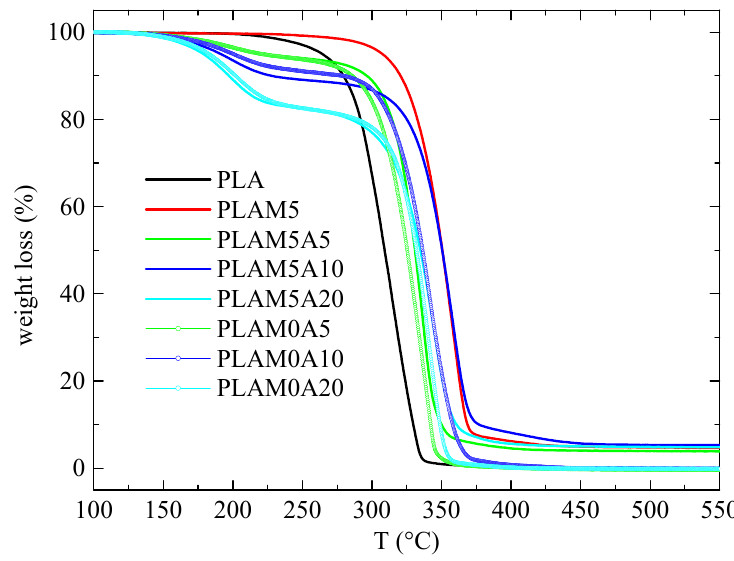
Figure 2. TGA curves under air atmosphere for the different materials analyzed.